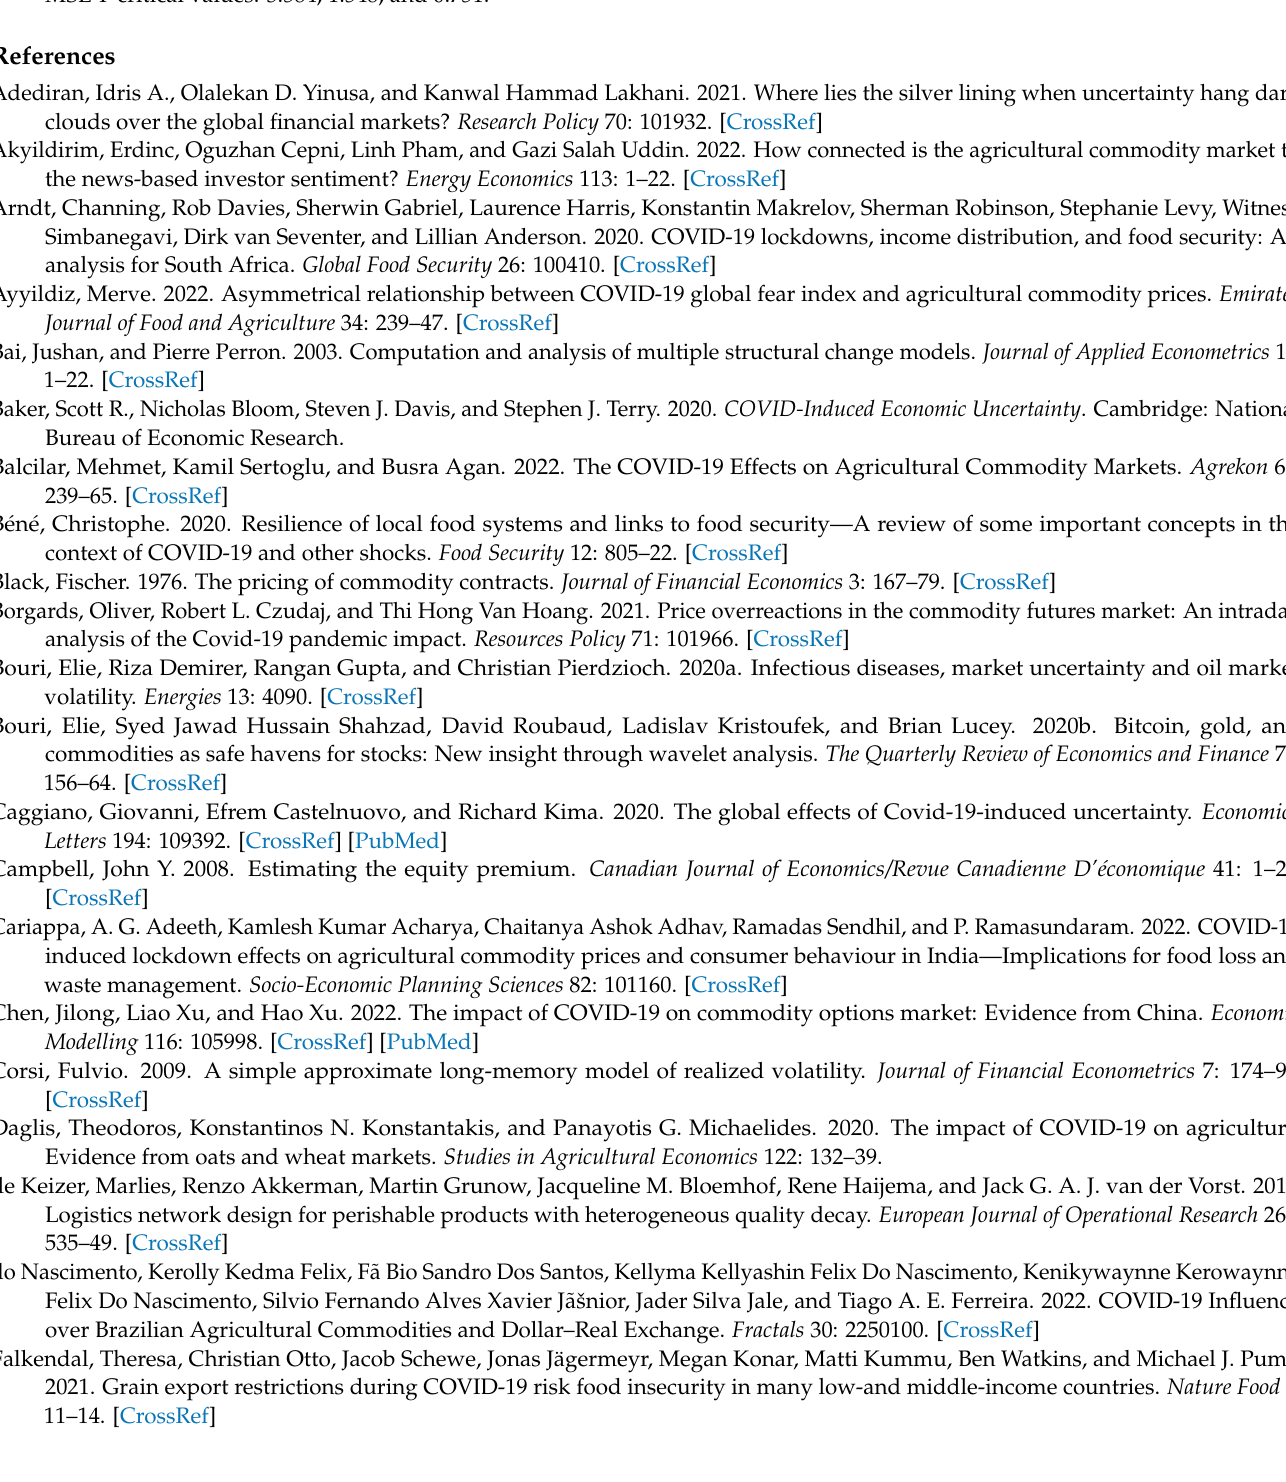
The profitability of businesses heavily depends on risk management strategies to hedge futures cash flow uncertainty. Lockdowns reduced the movement of goods and services and even brought some to zero, i.e., movements of imports and exports. Liao et al. (2018) noted the following three channels through which the fluctuation in the financial market can impact com- modity prices: macro-economy reflection channel, financial market information transmission channel, and market sentiment contagion